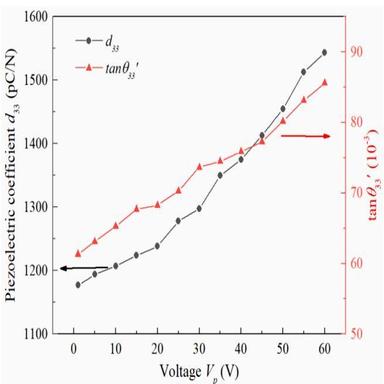
shows the variation curves of the piezoelectric coefficient d33 and the corresponding piezoelectric loss tanθʹ 33 under different driving voltages. As shown in the figure, the d33 value increases obviously with the increase of the driving voltage. To be specific, the d33 value increases from 1177 pC/N at 1 Vp to 1543 pC/N at 60 Vp, which represents an increase of 31.10 %. The rise in the d33 coefficient can be attributed to an escalation in the irreversible domain wall translation process, a ph